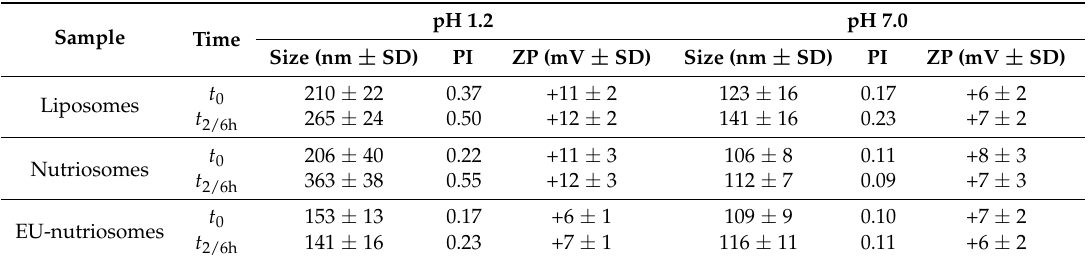
Table 2. Average size, polydispersity index (PI) and zeta potential (ZP) of liposomes, nutriosomes and EU-nutriosomes diluted and incubated at pH 1.2 and pH 7.0, at 37 ◦ C. The measurements were carried out immediately after the dilution ( t 0 ) and after 2 h at pH 1.2 ( t 2h ) or 6 h at pH 7.0 ( t 6h